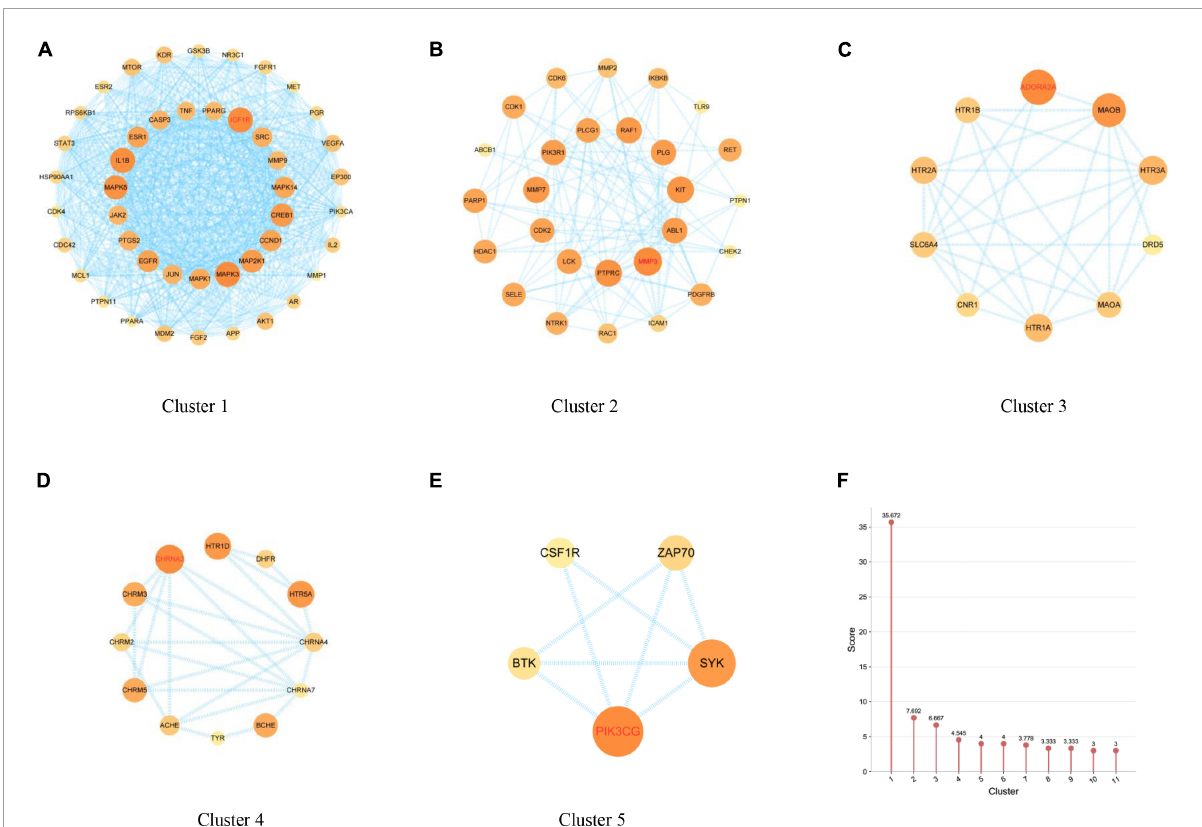
FIGURE7 (A–E) Discovery of clusters 1–5 using MCODE, which identifies densely connected regions. The seed nodes of each cluster are indicated in red font. (F) Comparison of MCODE scores for different